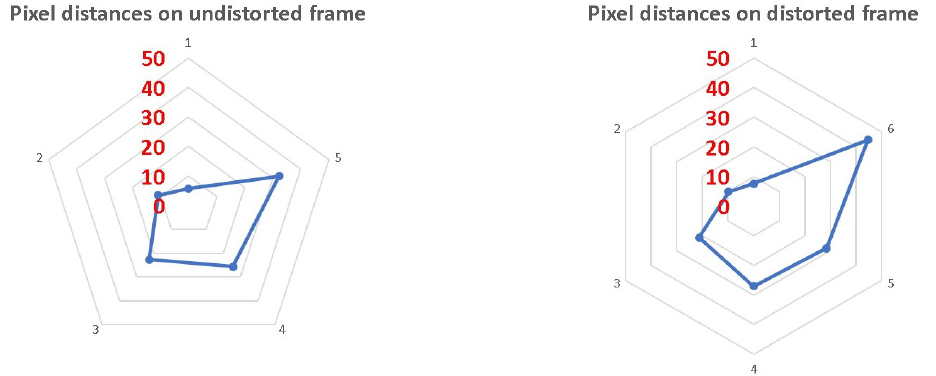
Figure 6. Distorted and undistorted frame distance deviations. Each pentagon in the graph represents a 10-pixel deviation from the real distance in the